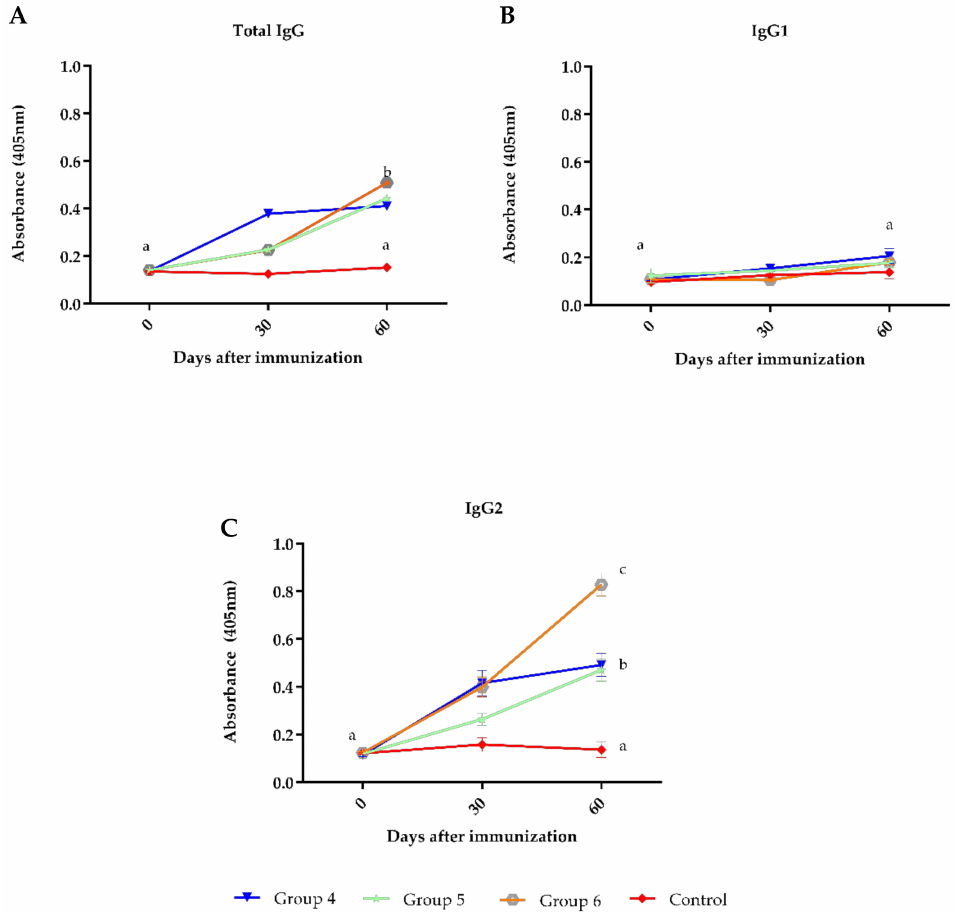
Figure 2. Antibodies to BoHV-1 evaluated by ELISA in sera of cattle immunized with commercial reproductive vaccines applied simultaneously with Clostridial or FMD vaccines. Group 4 = vaccine D; group 5 = vaccine D + Clostridial vaccine; group 6 = vaccine D + FMD vaccine and Control group (not vaccinated). Mean titers ± standard errors (SEM) are shown. Letters (a, b and c) highlight significant differences ( p < 0.05) between groups. A : Total IgG antibodies. B : IgG1 subclass antibodies. C : IgG2 subclass